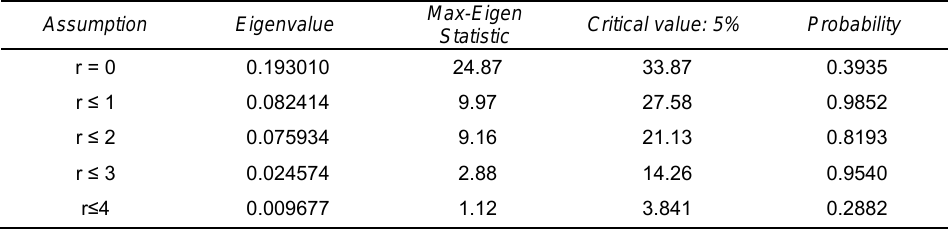
Table 3. Cointegration test: Maximum Eigenvalue